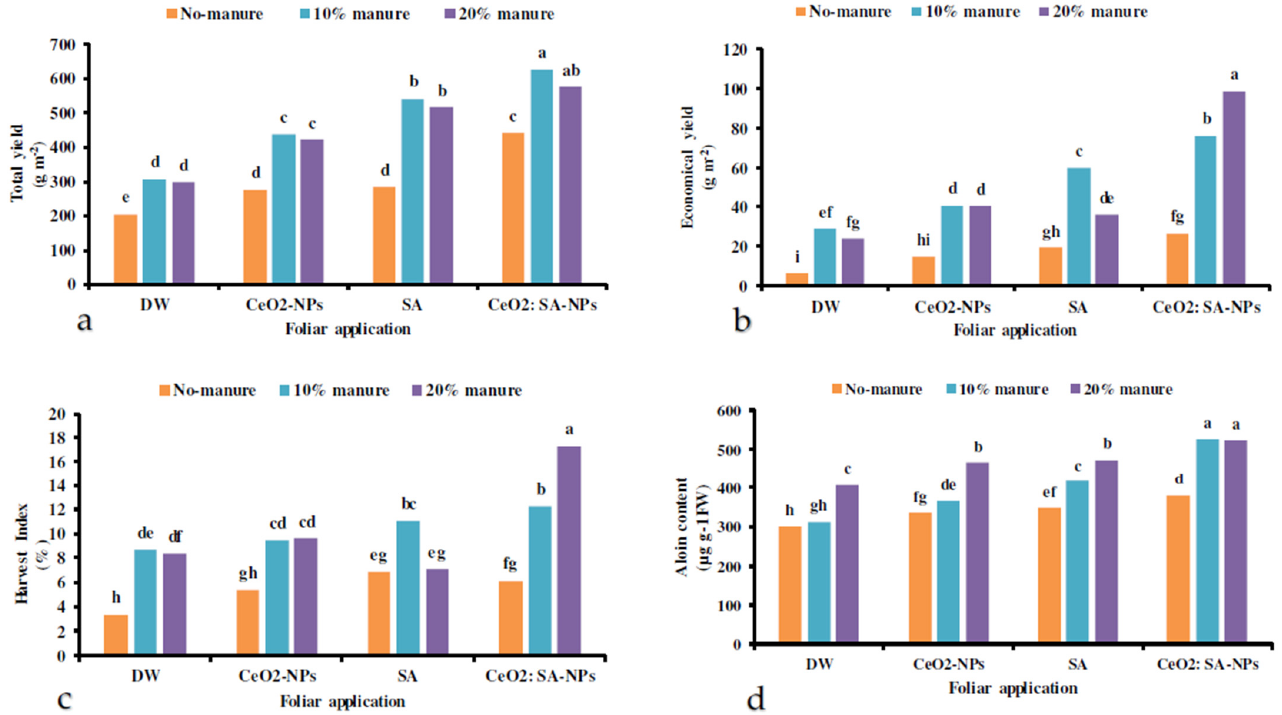
Figure 3. The interaction effects of soil-based animal manure application (no-manure, 10%, and 20% v / v ) and foliar spray of distilled water (DW), salicylic acid (SA), cerium oxide nanoparticles (CeO 2 -nanoparticles), and cerium oxide salicylic acid nanoparticles (CeO 2 : SA-nanoparticles) on the total yield ( a ), economic yield ( b ), harvest index ( c ), and aloin content ( d ) of Aloe vera L. plants. Significant differences among treatments are indicated by the different Latin letters on bars. Table 6. ANOVA for the effect of soil-based animal manure (no-manure, 10%, and 20% v / v ) use and foliar applications (no-foliar, salicylic acid, cerium oxide nanoparticles, and CeO 2 : SA-nanoparticles) on Aloe vera L. plants’ aloin content and yield traits.